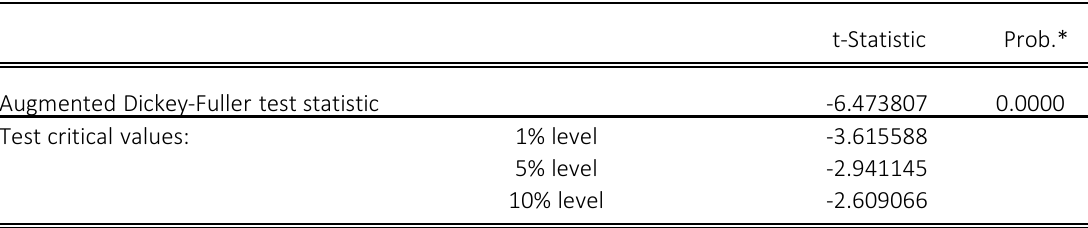
Figure 6. The results of the check on the stationary time series in the EViews program